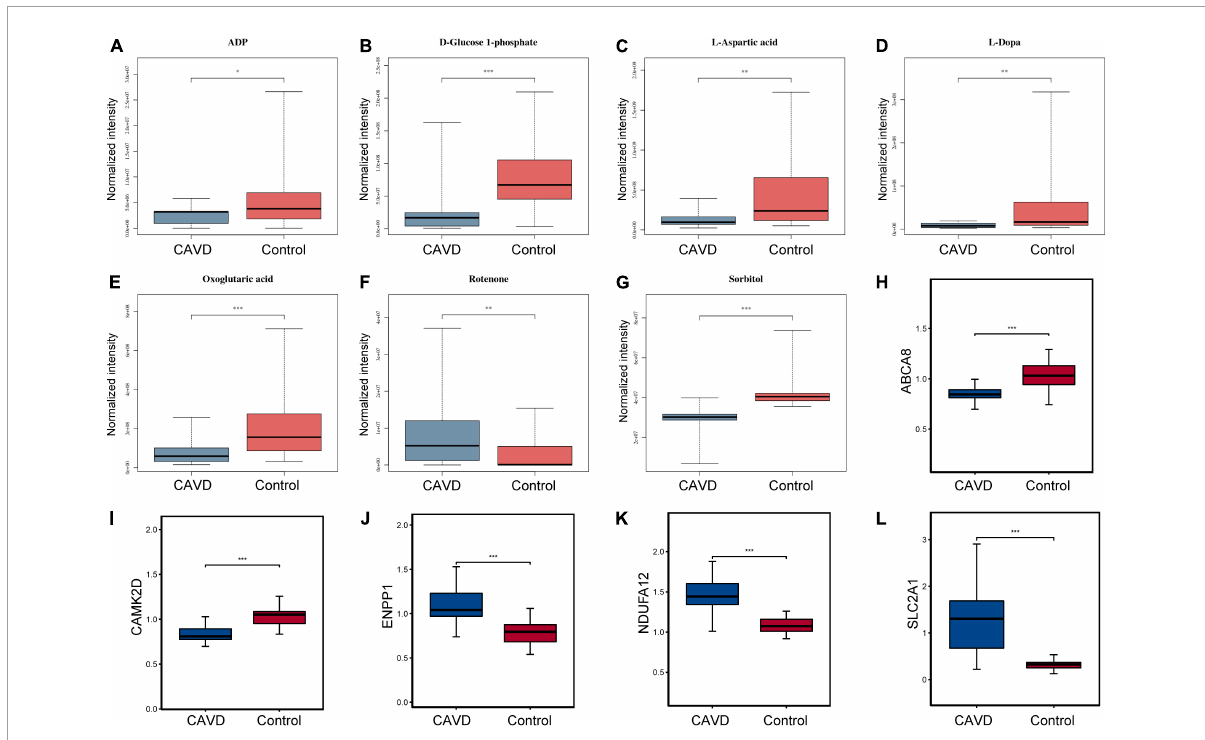
FIGURE8 Levels of hub metabolites and proteins. Boxplots show levels of panels (A–G) hub metabolites ADP, D-glucose 1-phosphate, L-aspartic acid, L-dopa, oxoglutaric acid, rotenone, and sorbitol and (H–L) hub proteins ENPP1, CAMK2D, ABCA8, SLC2A1, and NDUFA12 in CAVD and control samples. ∗ P < 0.05; ∗∗ P < 0.01; ∗∗∗ P < 0.001 vs. control. ABCA8, ATP Binding Cassette Subfamily A Member 8, CAMK2D, calcium2 + /calmodulin-dependent protein kinase II delta; ENPP1, ectonucleotide pyrophosphatase/phosphodiesterase